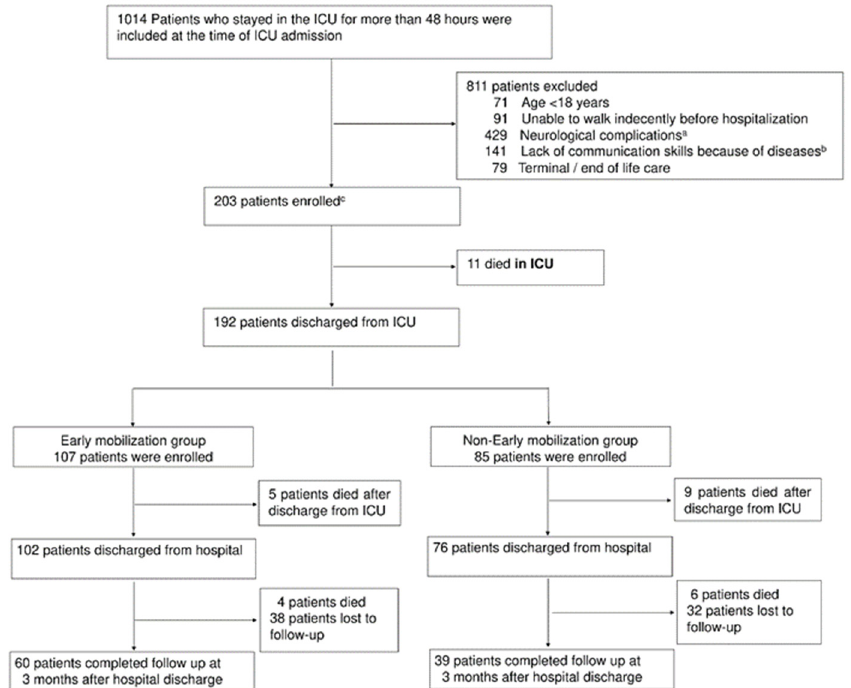
Figure 1. Study flow chart. ICU = intensive care unit. a Neurological complications include cerebral infarction, cerebral hemorrhage, acute subdual hematoma, acute epidural hematoma, traumatic subarachnoid hemorrhage, and encephalitis. b Diseases include depression, anxiety, schizophrenia, dementia, cerebral infarction, cerebral hemorrhage, and alcoholism. c Four out of nine hospitals could not enroll 25 patients and enrolled 14, 21, 22, and 21 patients.